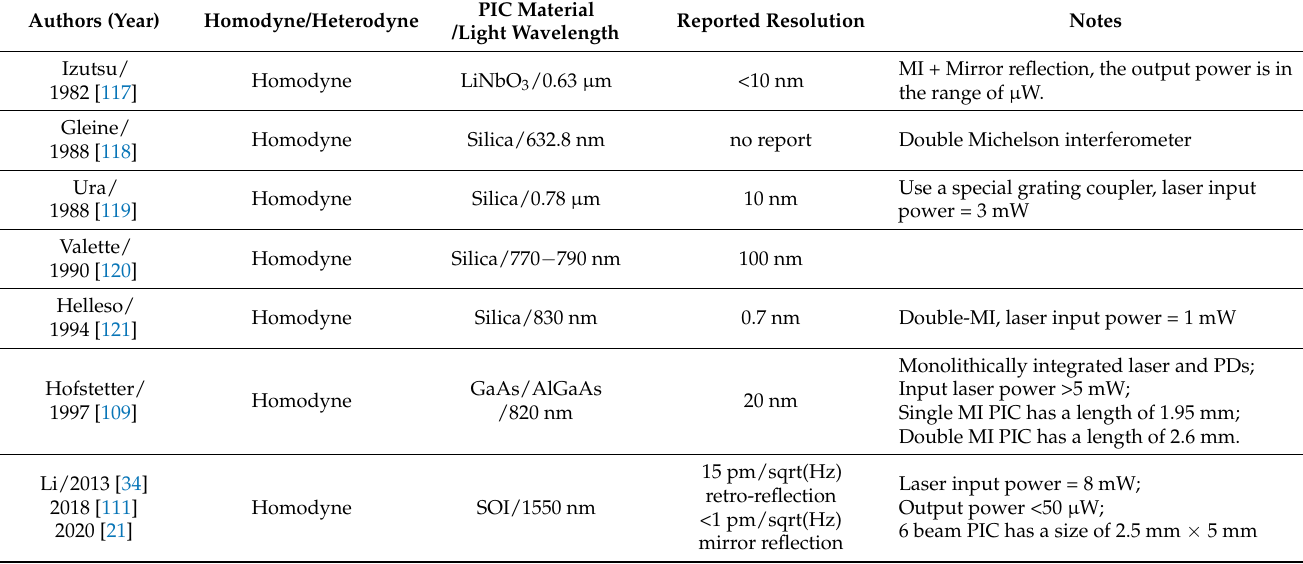
Table 2. A summary of different PIC-based LDV